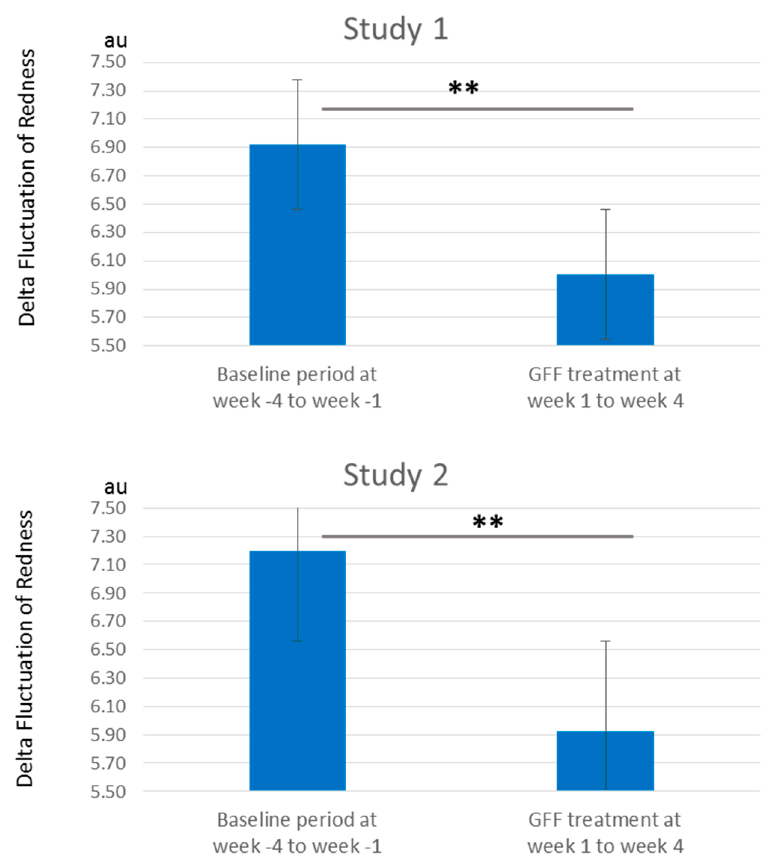
Figure 12. Delta fluctuation of redness. Delta fluctuation of redness is significantly decreased by GFF treatment from week 1 to week 4 compared with baseline period from week -4 to week -1. **; p <